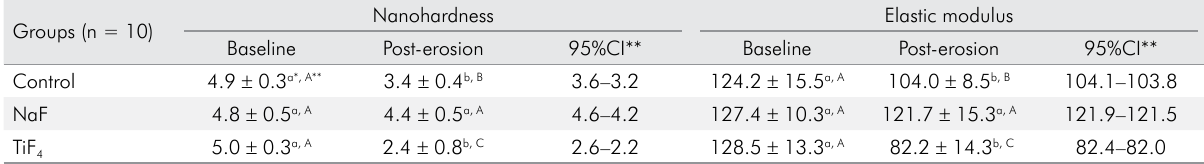
Table 2. Nanohardness and elastic modulus of groups after varnish application and erosive challenge. Groups (n = 10)